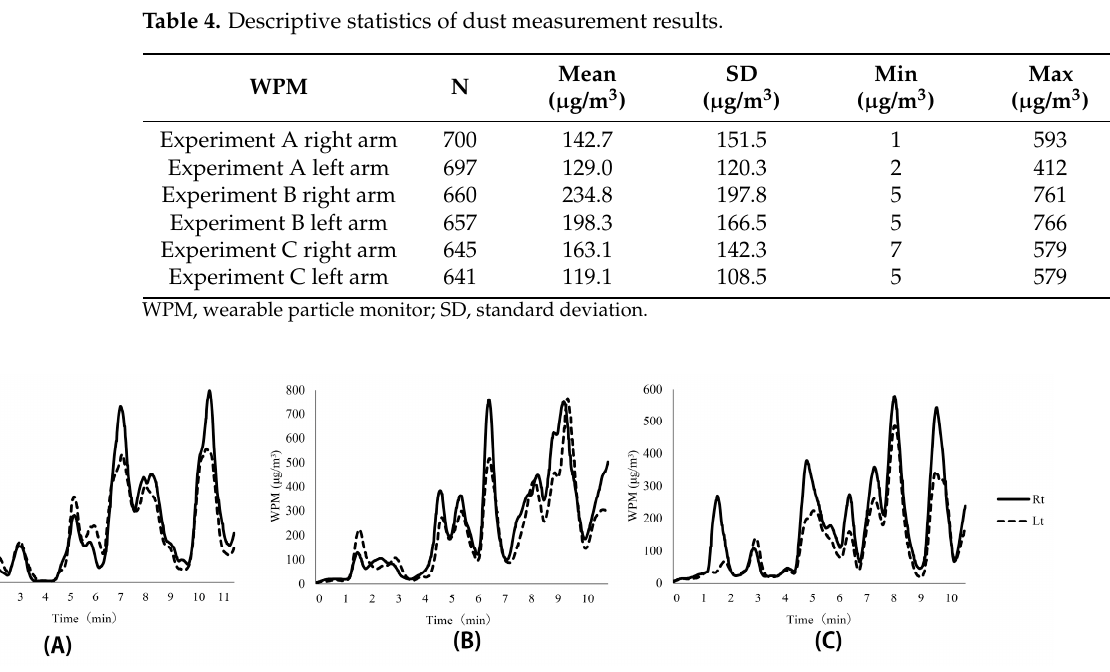
Figure 6. Results of dust measurements (Rt, right-hand side and Lt, left-hand side). ( A – C ) indicate Experiments A, B, and C, respectively. The source of the dust was located on the right side of the walking path. High values were reasonably predominant in the right-arm WPM.